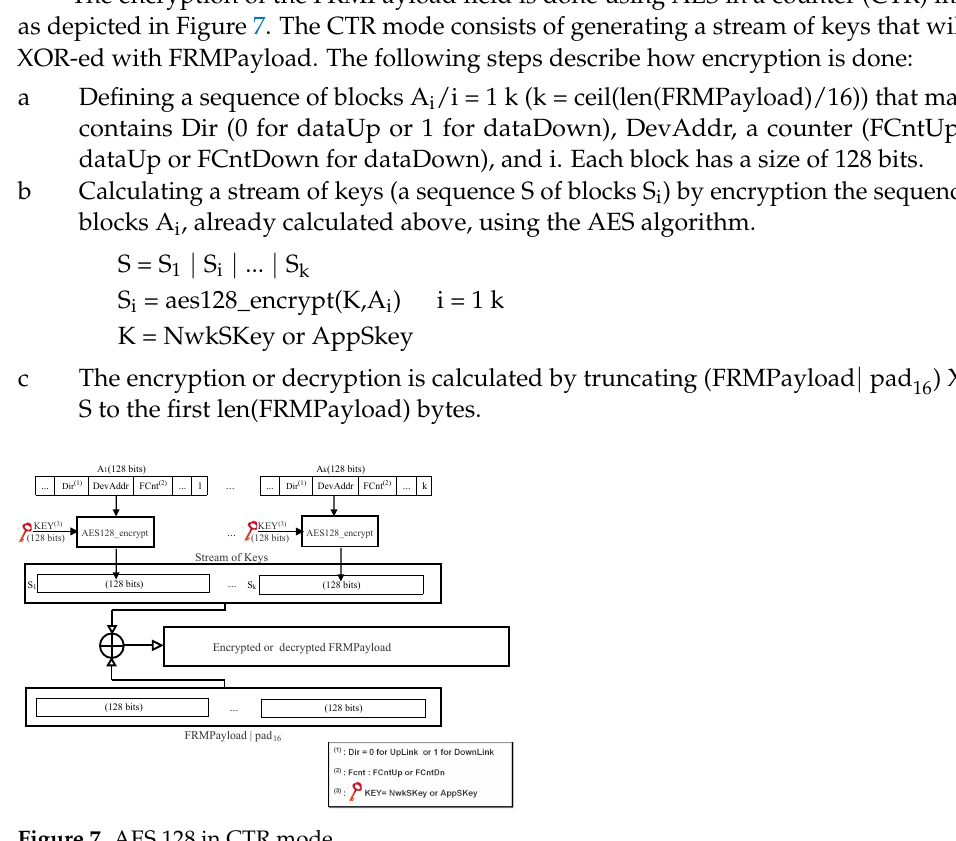
Figure 7. AES 128 in CTR